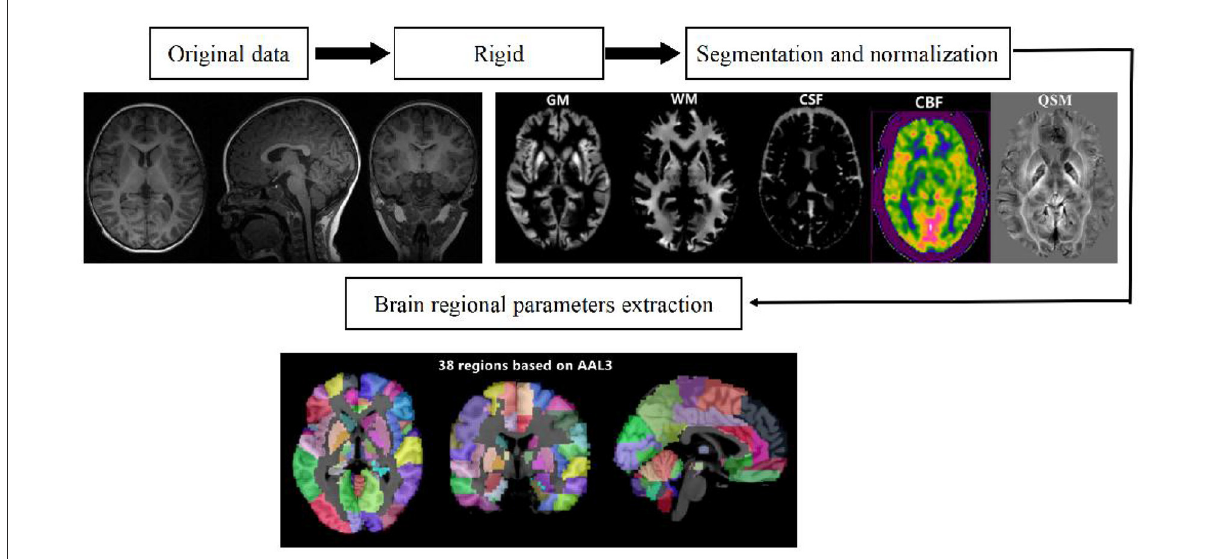
FIGURE1 Schematic diagram of the image processing and parameter extraction. Shilong Tang, Guanping Zhang, Qiying Ran, Xianfan Liu, Zhengxia Pan, Ling He. Quantitative susceptibility mapping shows lower brain iron content in children with attention-deficit hyperactivity disorder. Human brain mapping/equipment and method, pages no.2497, copyright (2022), with permission from. Reprinted from human brain mapping. 2022,